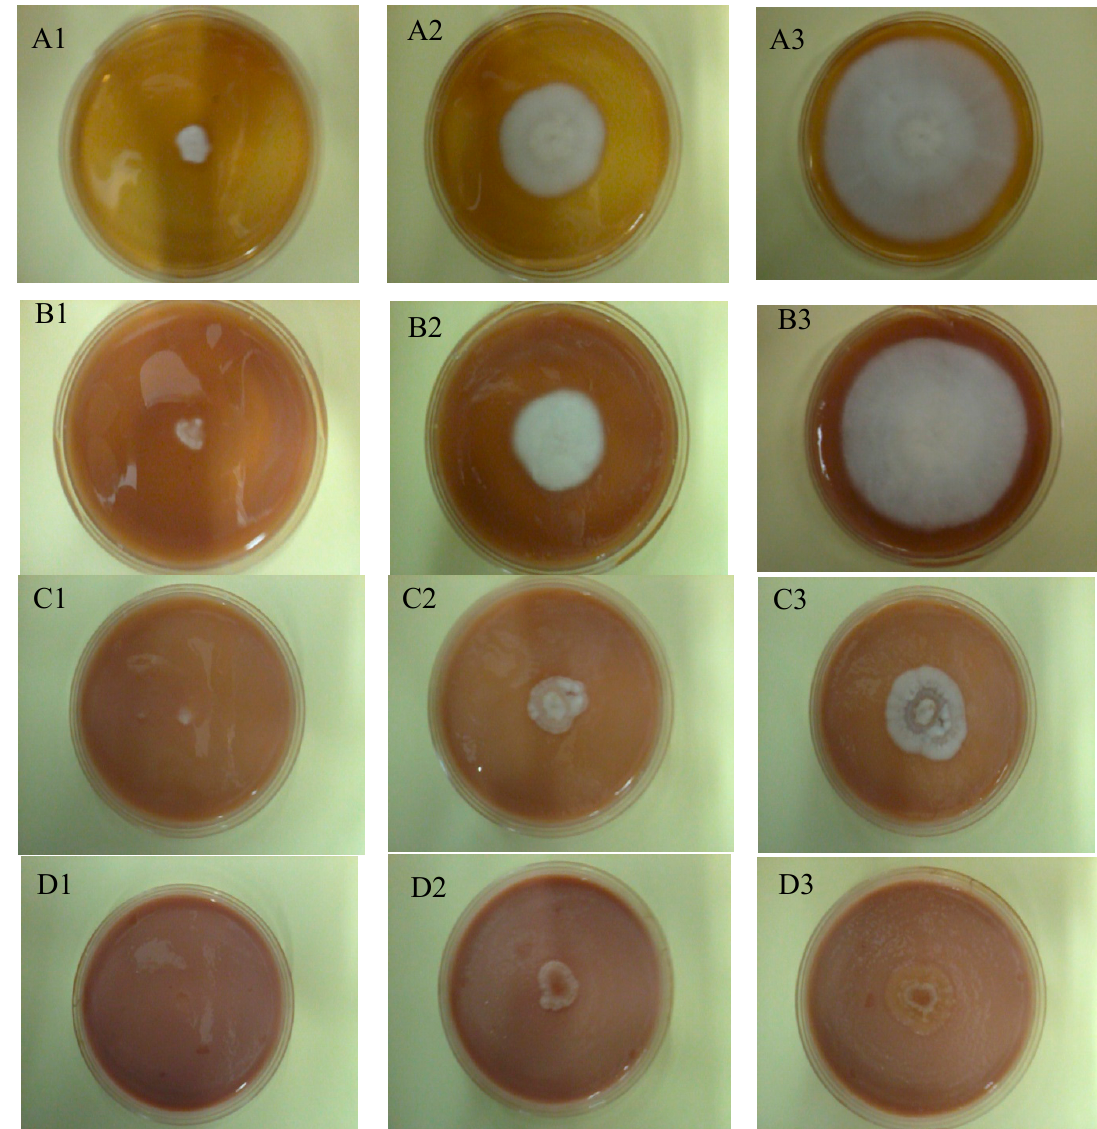
Figure 3. Geotrichum candidum growth on a solid medium supplemented with ellagitannins (REP)